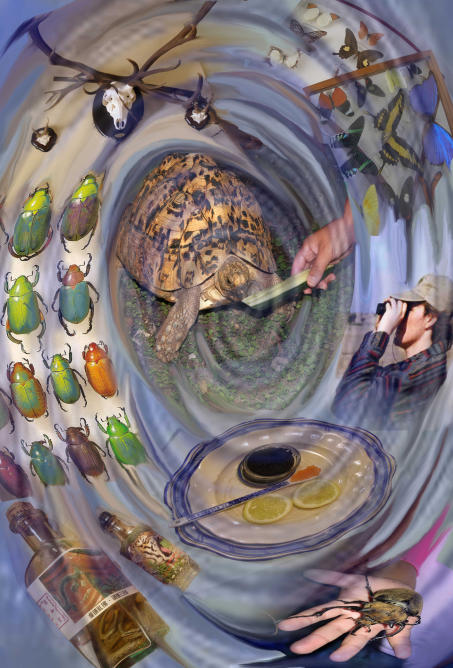
By placing an exaggerated value on rarity, humans can drive rare species into a vortex of extinction, through a process called the anthropogenic Allee effect. (Image: Maria Angulo)